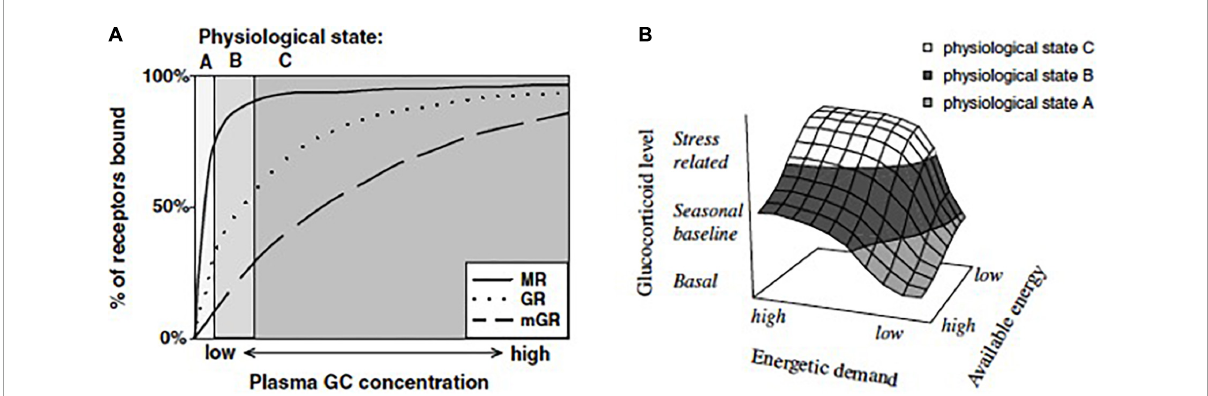
FIGURE2 (A) Hypothetical binding curves of the three known adrenal steroid receptors: the genomic mineralocorticoid receptor (MR), the genomic glucocorticoid receptor (GR), and the non-genomic membrane-associated glucocorticoid receptor (mGR). The MR binds glucocorticoids (GCs) with a higher affinity than does the GR. At least in birds, the mGR displays the lowest affinity for GCs (Breuner and Orchinik, 2009). These in vitro receptor properties suggest that low GC concentrations primarily bind the MR, whereas elevated levels bind the GR and may begin to bind the mGR. Thus, differences in the proportion of bound receptor types may provide a mechanism whereby different GC concentrations are able to produce specific physiological states. Low GC levels that predominantly activate the MR may promote physiological state A. Seasonal elevations in plasma GCs may support physiological state B through partial binding to the GR and the mGR. As GCs increase above the seasonal baseline, increased binding of all three receptor types may stimulate the physiological state C. (B) Relationship between energetic demand (allostatic load), available energy, and glucocorticoid (GC) level in the promotion of physiological states. Energetic demand can change with daily activity patterns or with life-history stage and may also increase as a consequence of challenging perturbations in the environment. Although animals respond to energetic demand by secreting GCs, this response may be attenuated by high energy availability, i.e., abundant food resources and/or internal energy depots. For example, even when energy demand is high, animals that have access to sufficient energy stores may remain within the reaction norm for a particular life-history stage and may not increase plasma GCs above a seasonal baseline. Within seasonal baseline levels, GCs may promote processes representative of physiological state B. However, as energy stores become unavailable, GCs may increase to stress-related concentrations at which point they support increasingly complex physiological states to allow an individual to cope. From Landys et al. (2006) with permission courtesy of